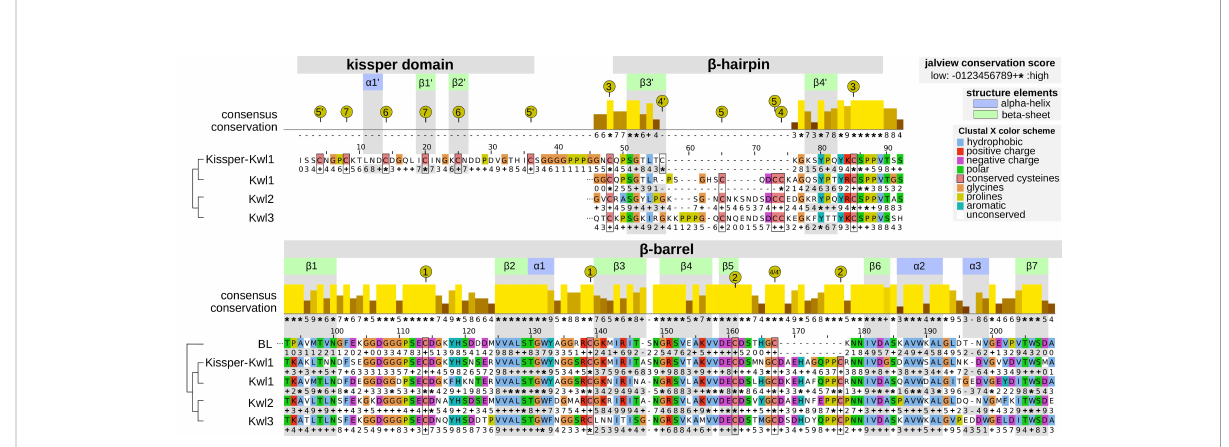
FIGURE 3 Aligned consensus sequences (without signal peptide) with secondary structure information of the Kiwellin subfamilies and a set of 391 BL proteins for reference. The conservation score of the consensus alignment for all Kiwellins is indicated above. The family-speci fi c conservation is shown below the respective sequence: − (mostly gaps), 0 … 9, + (property conservation, ascending), ∗ (perfect conservation). Amino acids are colored according to their physicochemical properties. Positions and secondary structure elements were drawn corresponding to Kissper-Kwl1. Green represents b -sheets, blue a -helices. Numbered, yellow circles indicate the cysteine residues forming disul fi de